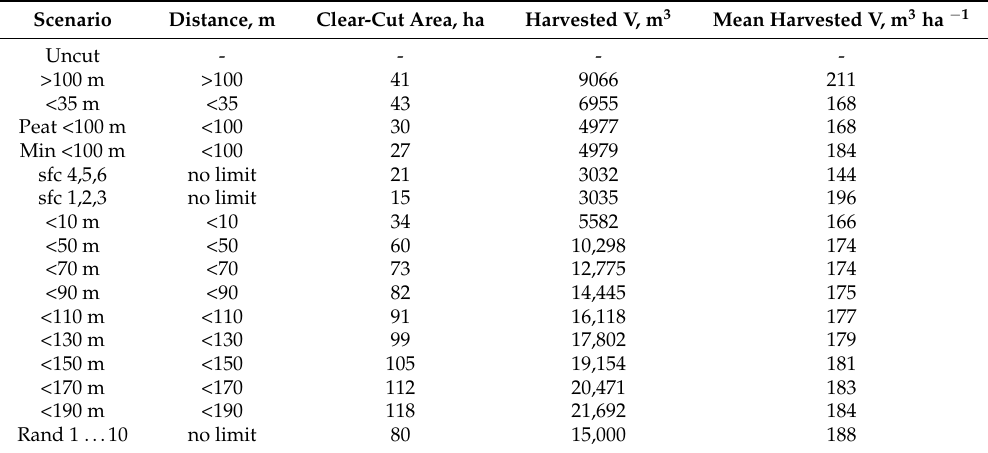
Table 2. Clear-cut scenarios calculated for Catchment 2 (area 166 ha). In all scenarios, clear-cut was only conducted to grid where stand volume exceeded 100 m 3 ha − 1 .